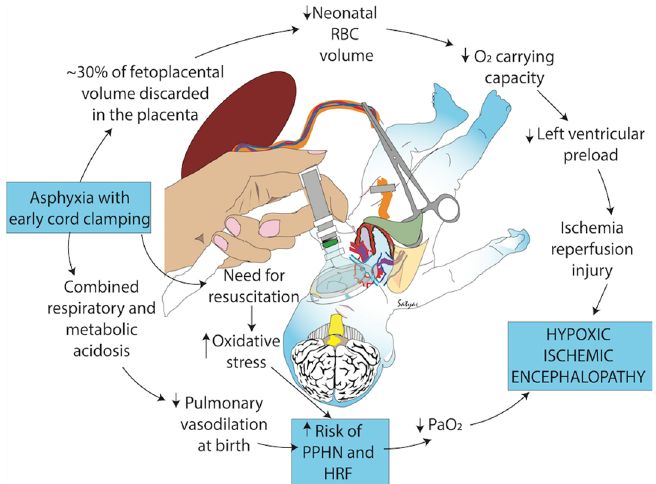
Figure 1. Negative consequences of early cord clamping in depressed infants who may have asphyxia and an increased need for resuscitation. Early cord clamping reduces whole blood and red blood cell (RBC) volume and increases the fetal blood left in the placenta. Hypovolemia and hypoxemia contribute to cerebral hypoperfusion and ischemia and exacerbate pulmonary hypoperfusion and hypertension. Studies have shown increased oxidative stress with early cord clamping compared to delayed cord clamping and umbilical cord milking. Oxidative stress contributes to ischemia and other neonatal morbidities such as hypoxic respiratory failure (HRF), hypoxic-ischemic encephalopathy and persistent pulmonary hypertension of the newborn (PPHN). Copyright Satyan Lakshminrusimha, MD, Sacramento, CA, USA. Used with permission